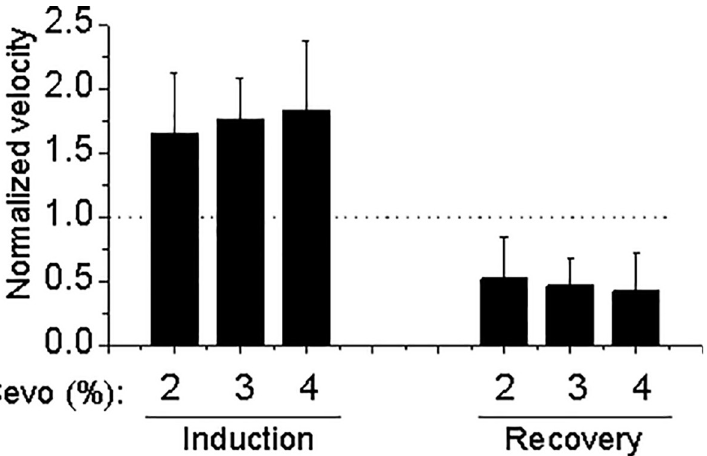
pattern (hyperactivity during induction and hypoactivity during recovery) in the mouse model was observed at all tested concentrations ranging from 2–4% sevoflurane with undetectable statistical significance among the different concentrations.